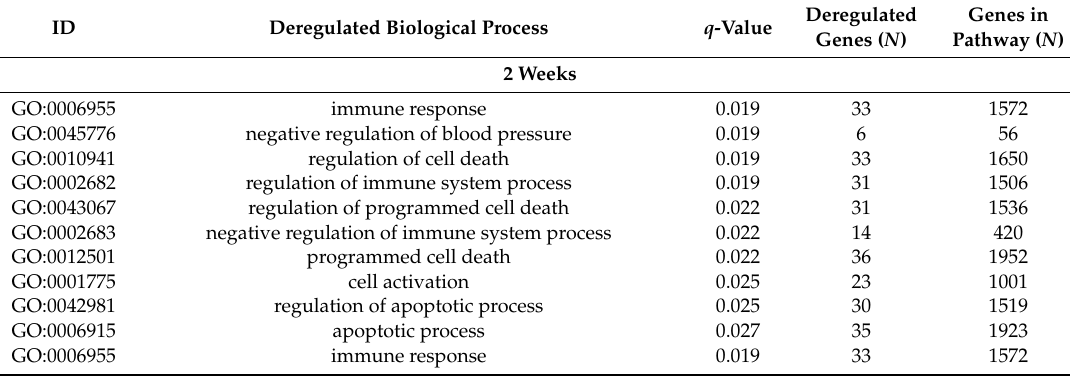
Table 2. Selected unique biological processes deregulated after inhalation of CuO